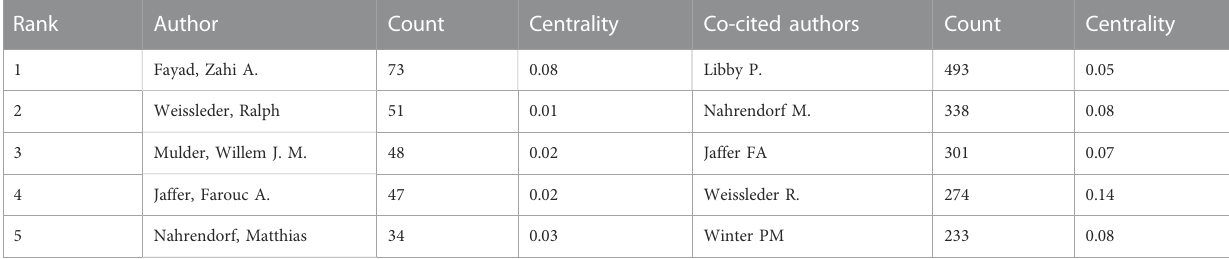
TABLE 3 Top fi ve productive authors and most co-cited authors on molecular imaging research in AS. Rank Count